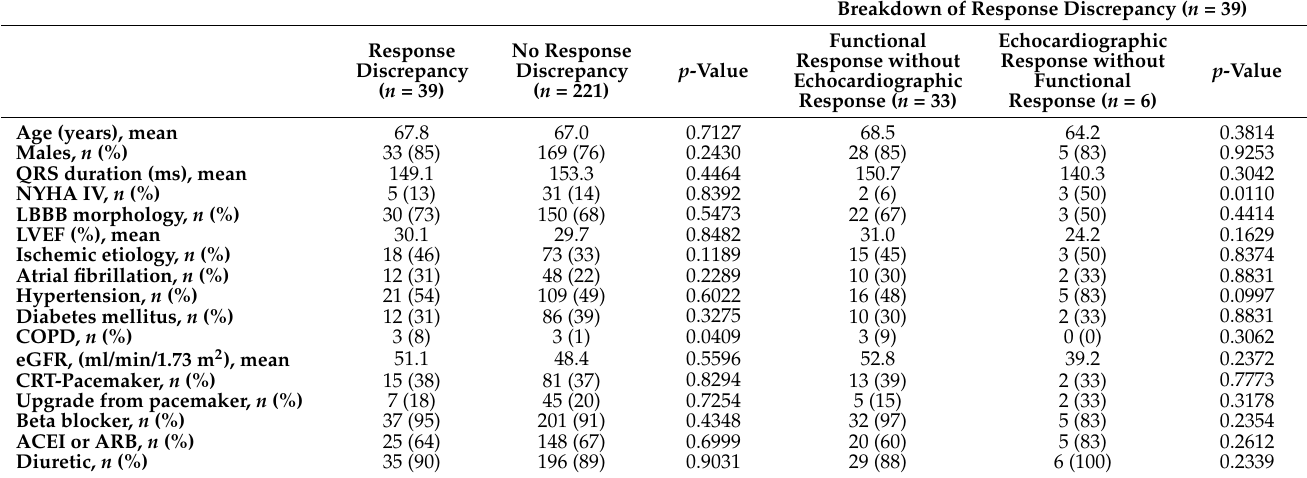
Table 3. Characteristics of patients with response discrepancy between two criteria.